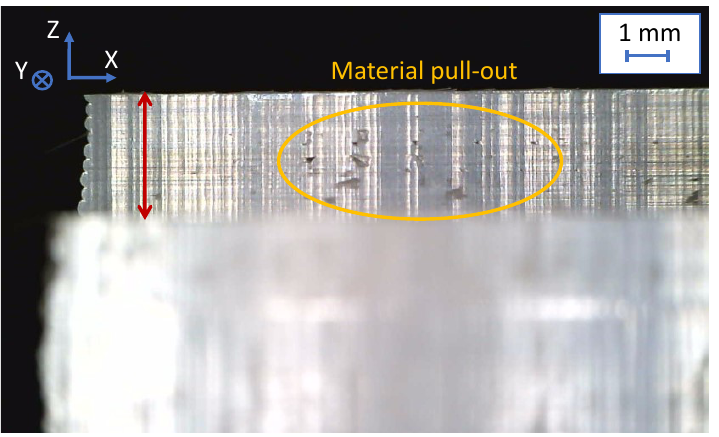
Figure 15. Surface topography of the qualification point for the universal tool, v c = 270 m/min, f z = 0.030 mm/tooth, a p = 3 mm, and a e = 0.5